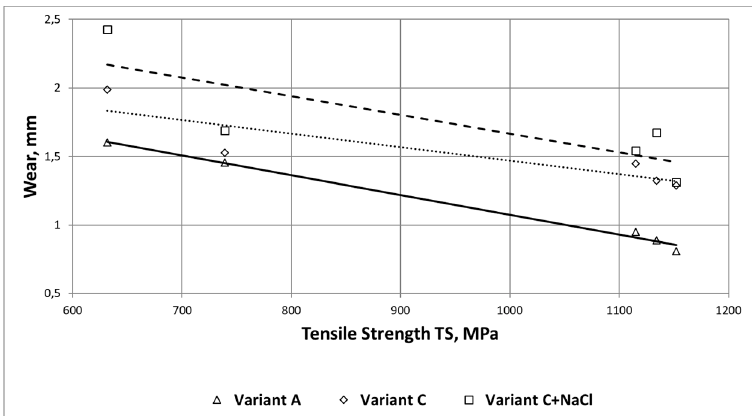
Figure 14. The δ MAX wear parameter curves in the function of maximum strength, determined for the analyzed wear variants.